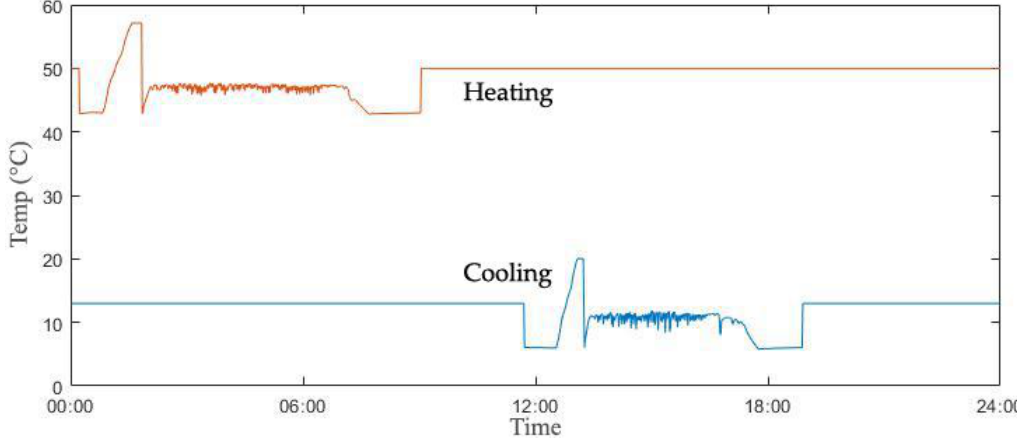
Figure 9. Signals for the amount of supply air by the FIS control.